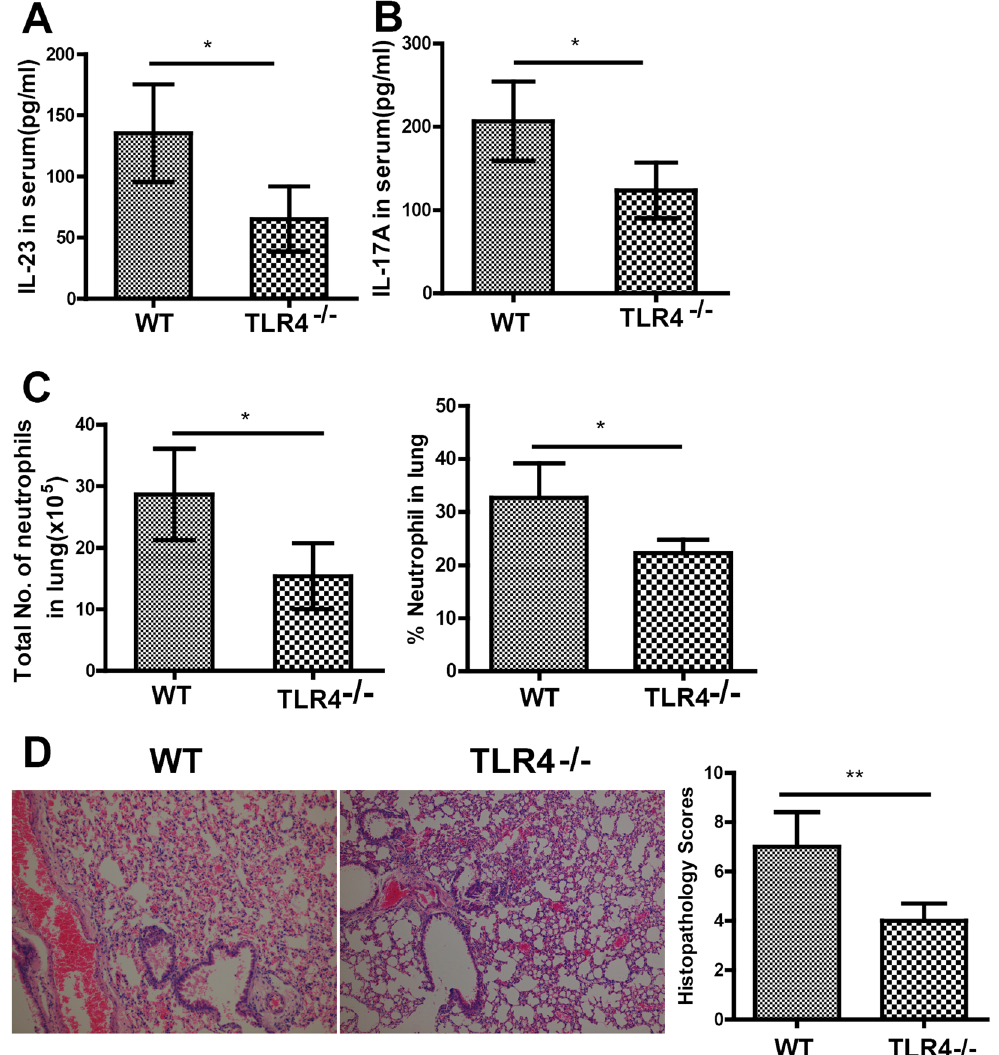
Figure 6. TLR4 mediates the activation of HMGB1-IL-23-IL-17A axis following PQ challenge. PQ gavage was performed on TLR4 − / − or wild-type (WT) C57BL/6 mice. At 72 h after PQ challenge, TLR4 − / − group presented significantly lower levels of the serum IL-23 ( A ), the serum IL-17A ( B ), the number and percentage of lung- infiltrating neutrophils ( C ), and the lung injury (200 × ) ( D ). All data were presented as mean ± SD for all mice in each group and compared between the TLR4 − / − and WT mice. * P <